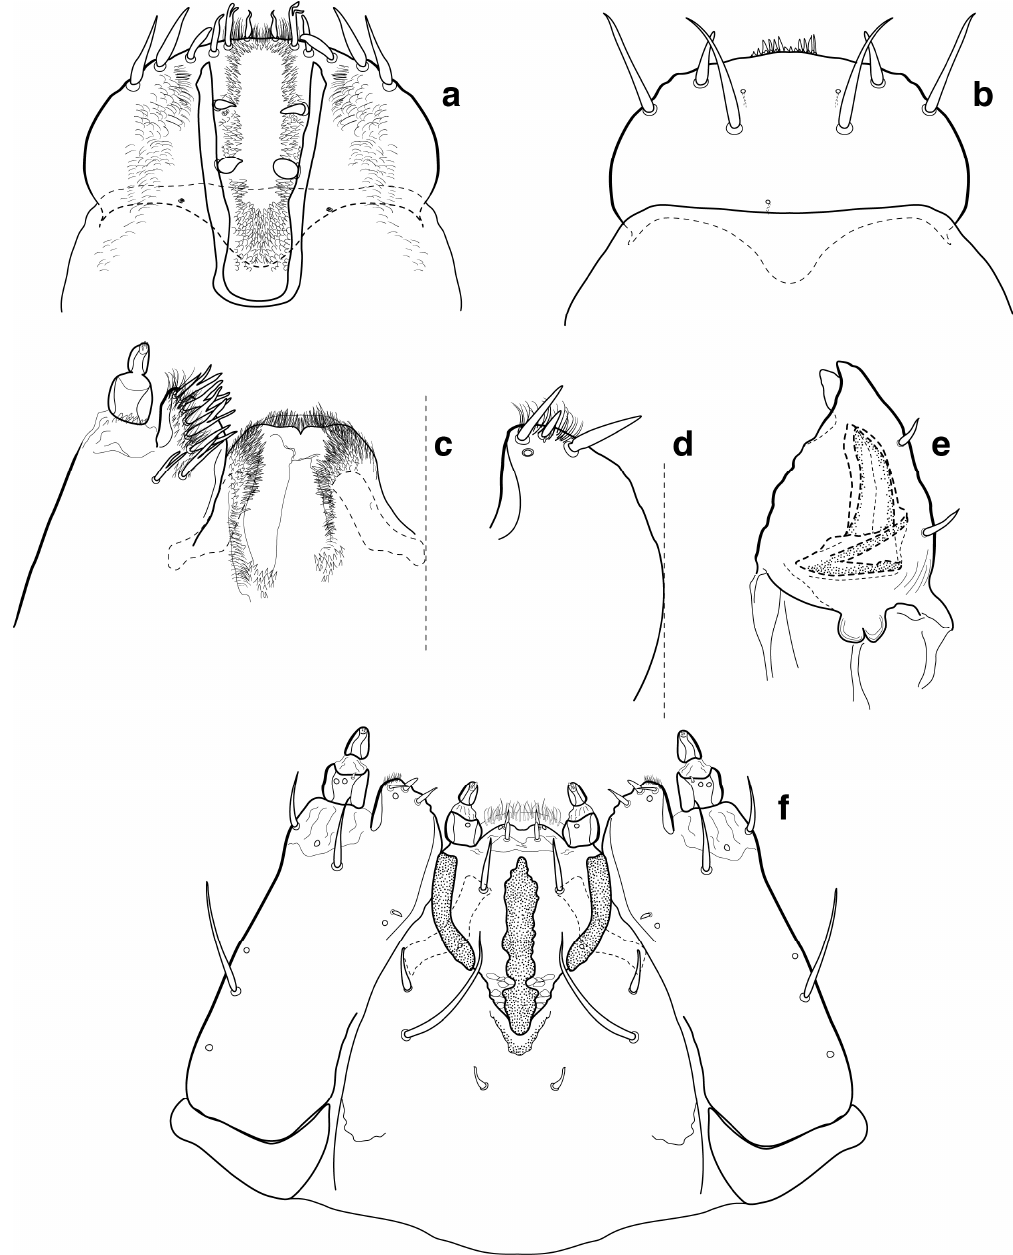
Figure 72. Paramasius cristulatus mouthparts: ( a ) epipharynx; ( b ) labrum; ( c ) maxillae and hypopharynx, dorsal view; ( d ) mala, ventral view; ( e ) mandible, internally with scerotized process; and ( f ) labio-maxillary complex, ventral view.